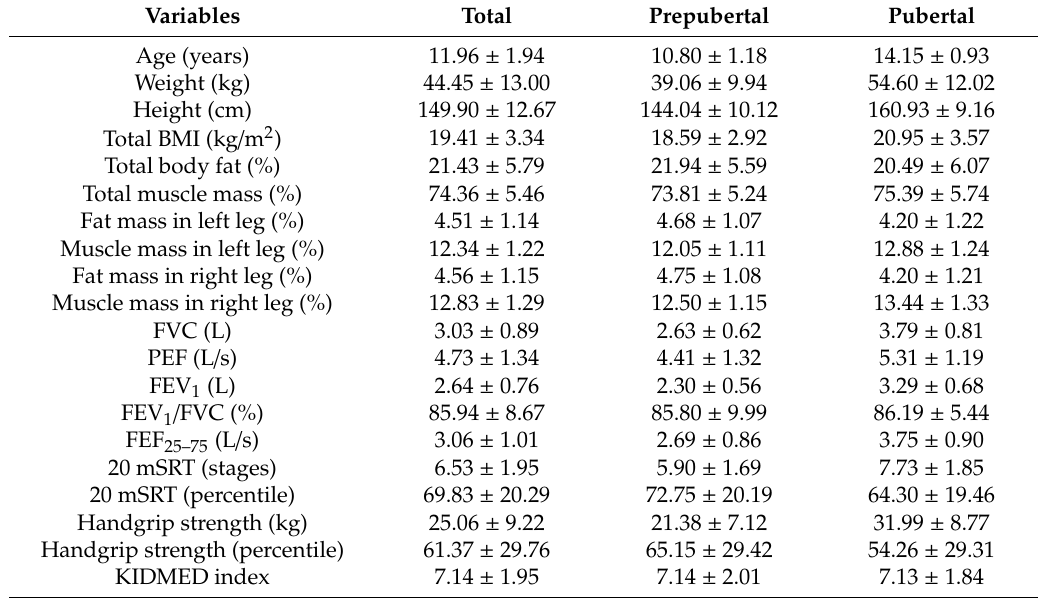
Table 1. Characteristics of the